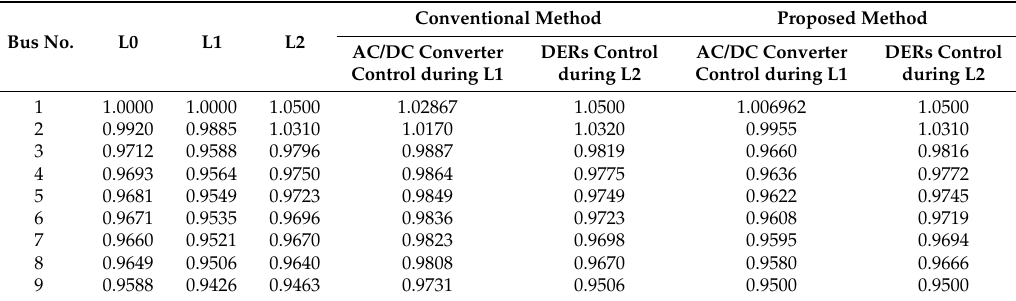
Table 3. The results of voltage profiles for case 1 (Unit: per